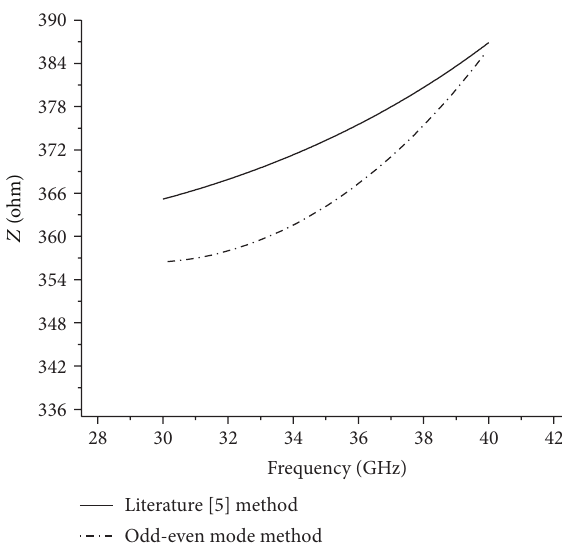
Figure 7: Comparison with odd-even mode and literature [5] method.